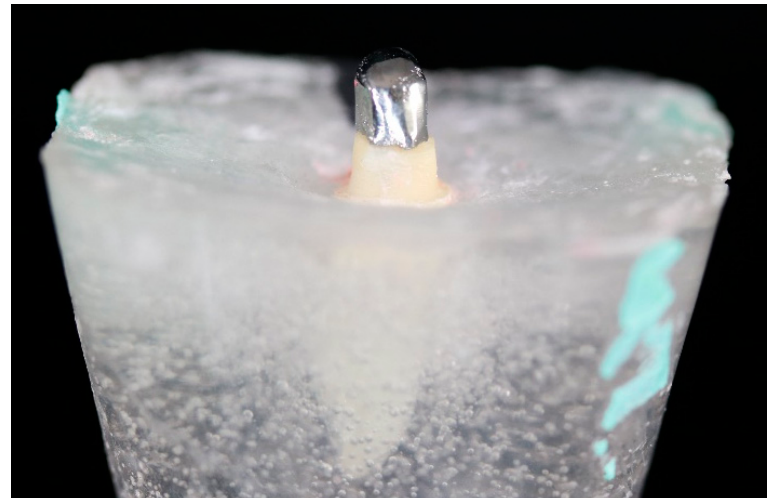
Figure 6. View of a cemented post and core.